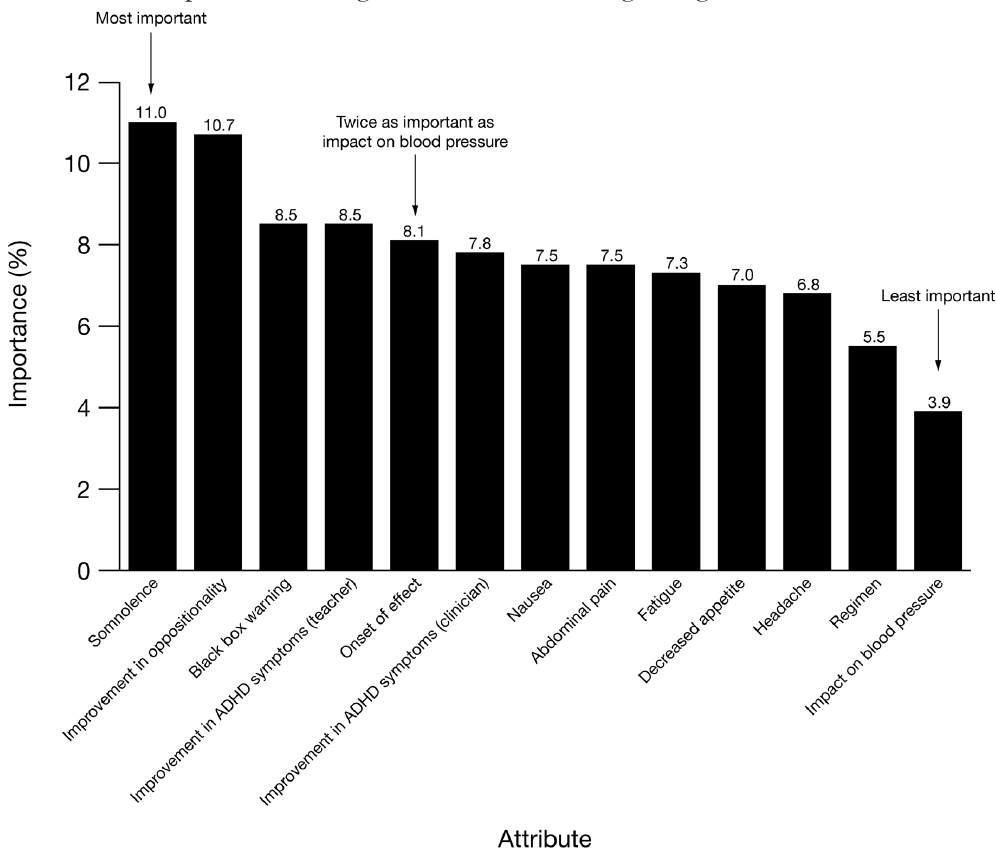
Figure 2. Mean Percent Importance Ratings for Attributes among